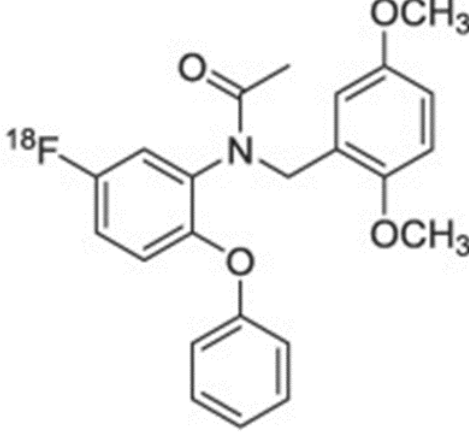
Figure 8. Chemical structure of N-(2,5-Dimethoxybenzyl)-N-(5-fluoro-2-phenoxyphenyl)acetamide (DAA1106) labeled with 18 F belonging to the phenoxyphenylacetamide (DAA1106) labeled with ¹⁸F belonging to the phenoxyphenylacetamide family.